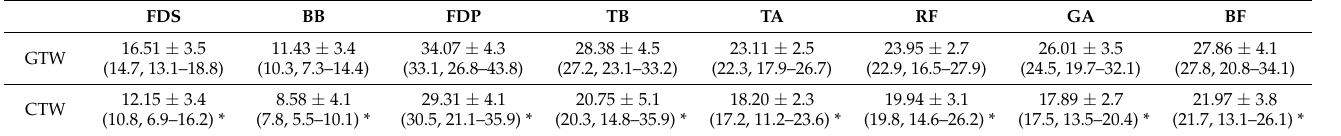
Table 4. Upper and lower extremity muscle activity in uneven terrain.